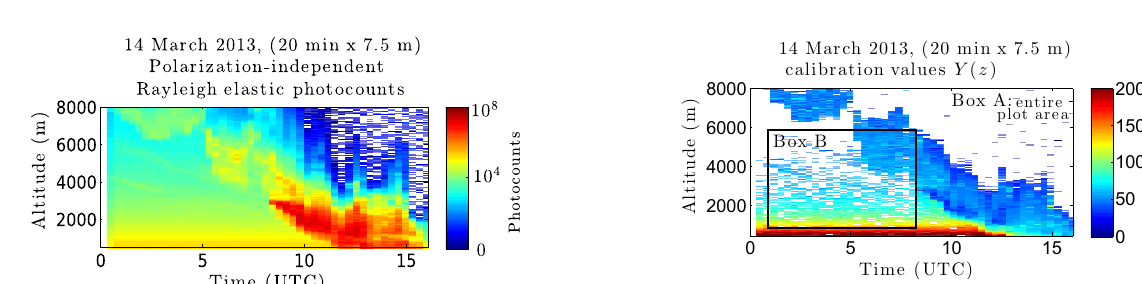
Figure 12. Polarization-independent Rayleigh elastic photocounts from 14 March 2013. Note the logarithmic colour bar used for this plot. These photocounts have been dead-time corrected, co-added, and background subtracted.